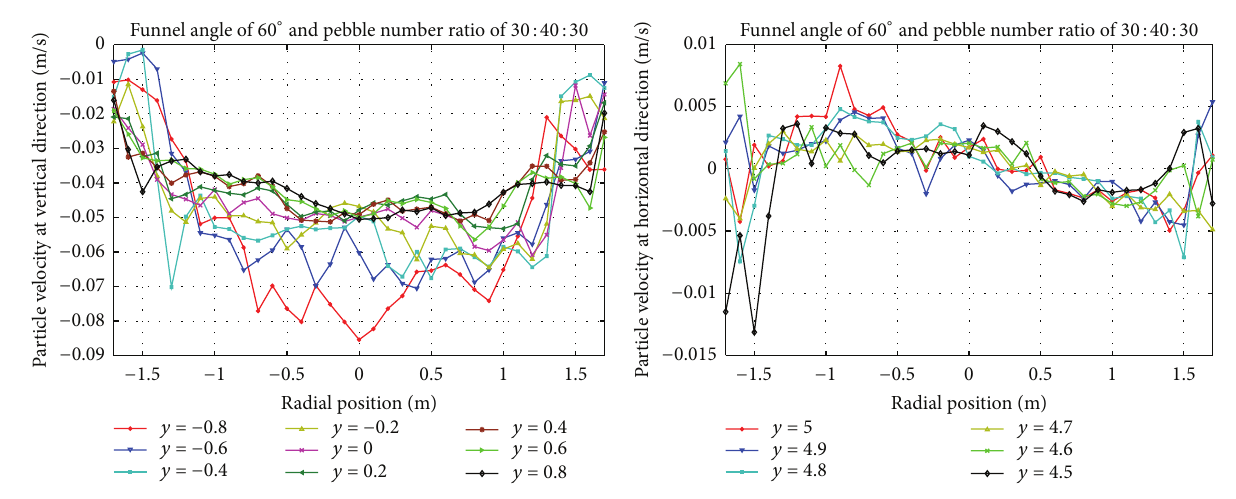
(c) Vertical velocity distribution of pebbles with funnel angel of 60 ∘ at cone region Funnel angle of 60 ∘ and pebble number ratio of 30 : 40 : 30